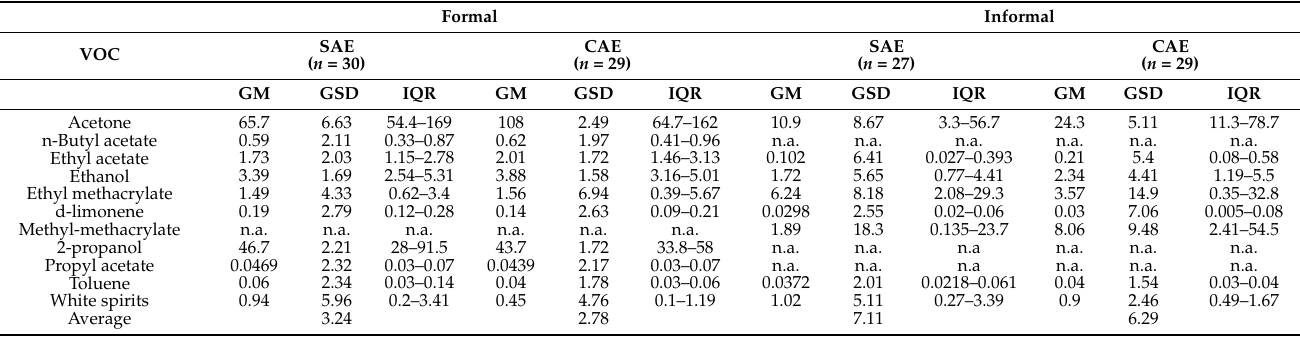
Table 2. Summary statistics of the VOC shifts in average concentrations (mg/m 3 ), which were selected for further analysis.